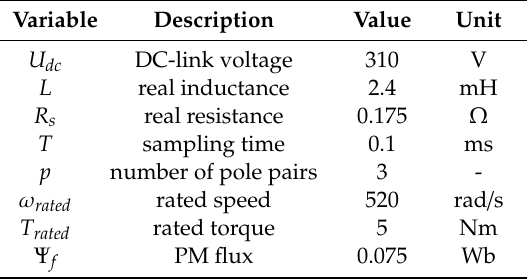
Table 1. Surface-mounted permanent magnet synchronous motor (SPMSM) parameters.